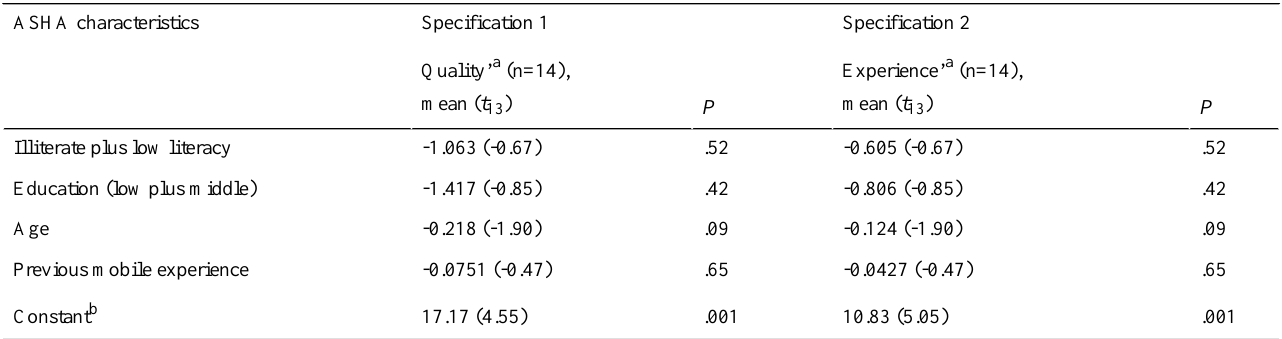
Table 12. The effect of ASHA characteristics on the relationship between CommCare proficiency and quality/experience of care.